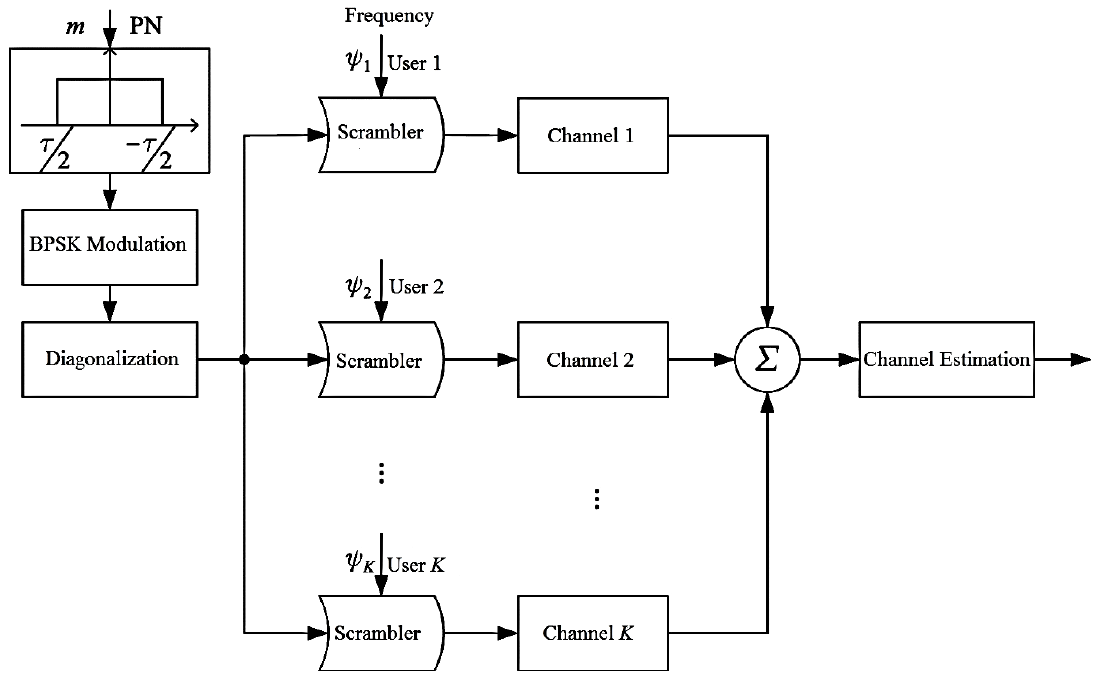
Figure 5. Pseudo-random code pilot design scheme.